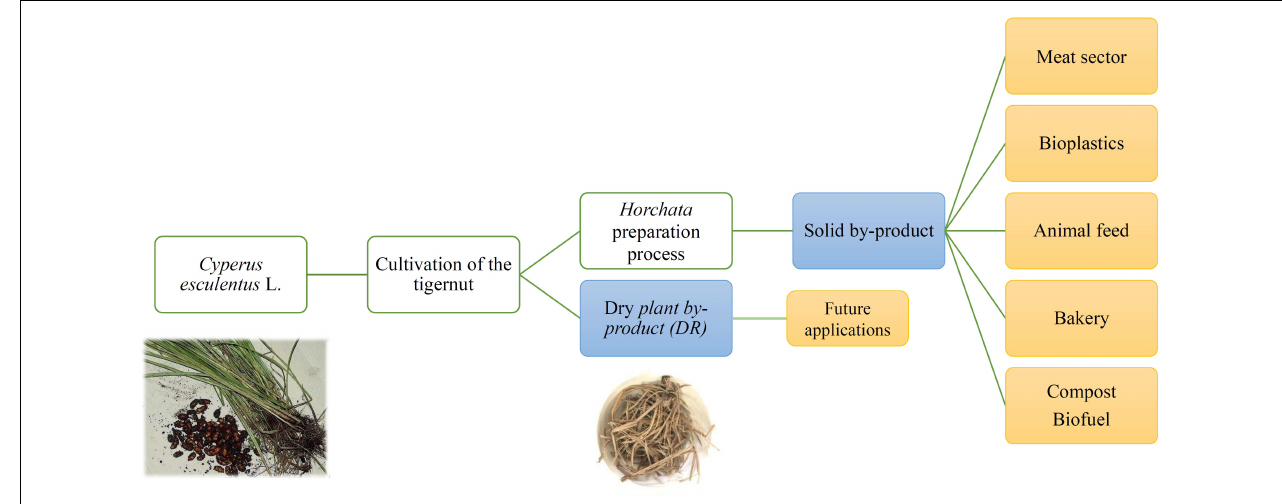
FIGURE 1 | Scheme of by-products generated during horchata